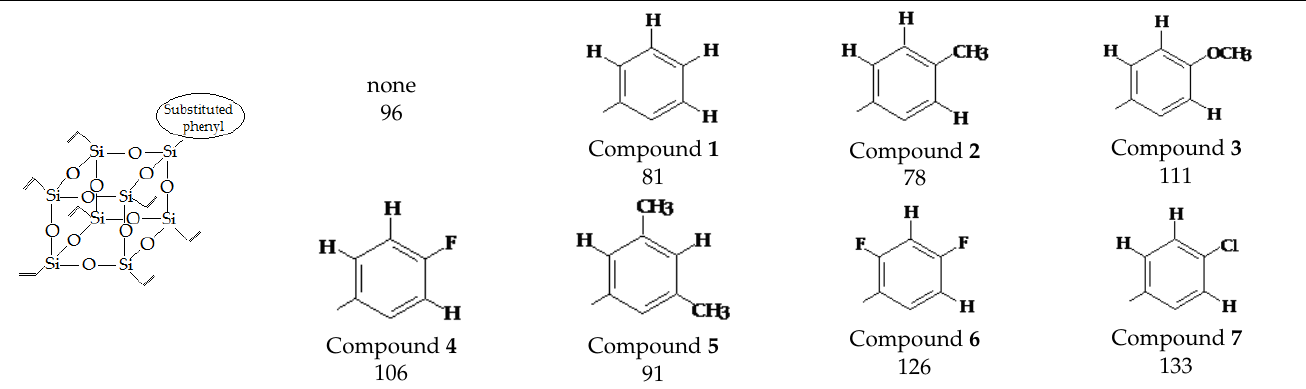
Table 5. Modified POSS structures and the activation energy (kJ mol − 1 ) for their oxidation [130].